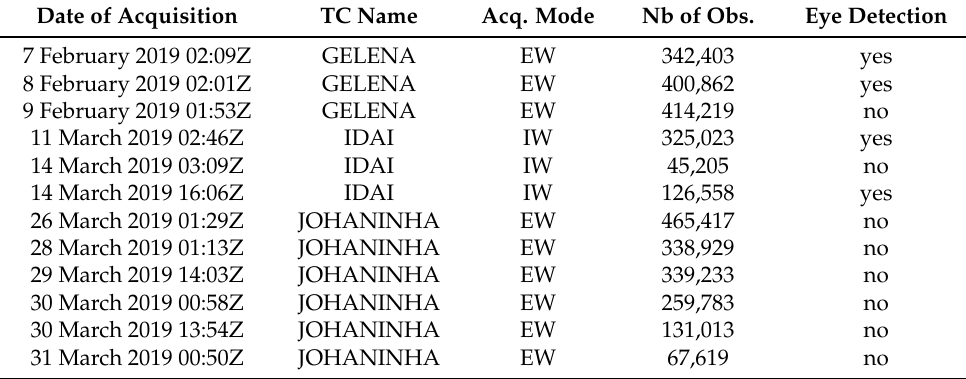
Table 1. List of SAR images available in AROME OI 3D-Var domain for the 2018–2019 TC season with date of acquisition, associated TC name, acquisition mode, number of observations within each image and detection of the TC eye or